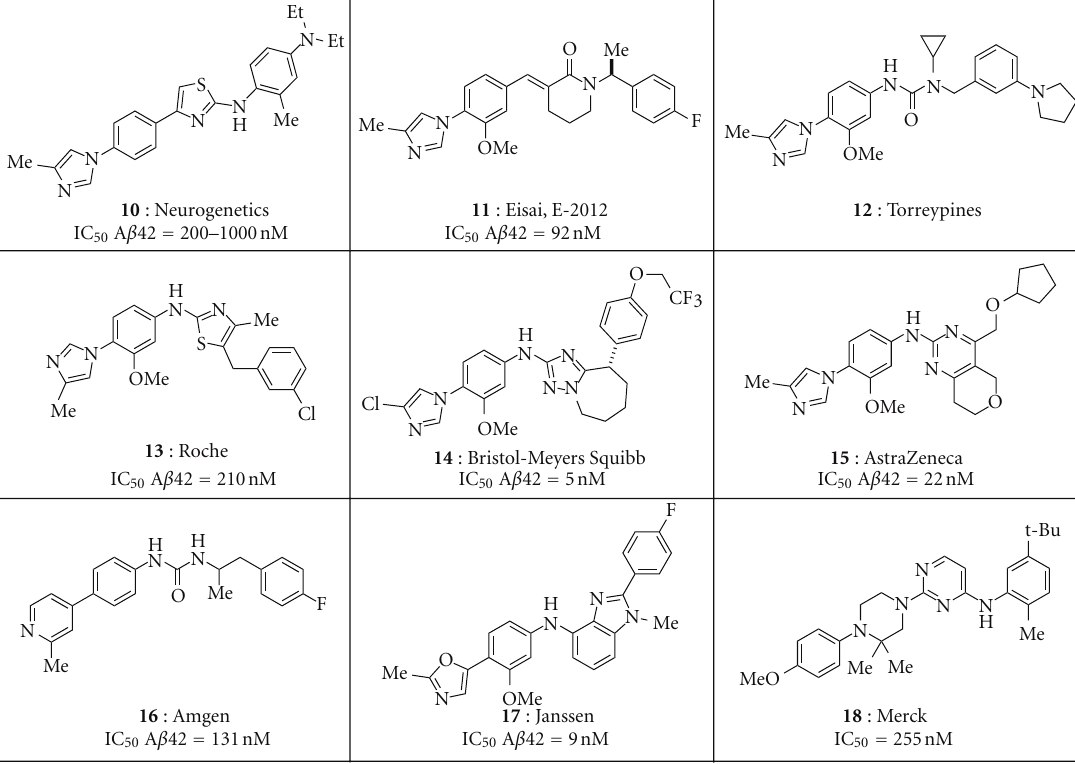
Figure 3: Representative aryl imidazole inspired GSMs [30–33]. Compounds 16–18 are the most unique because the aryl imidazole has been replaced by a bioisostere [34–36].